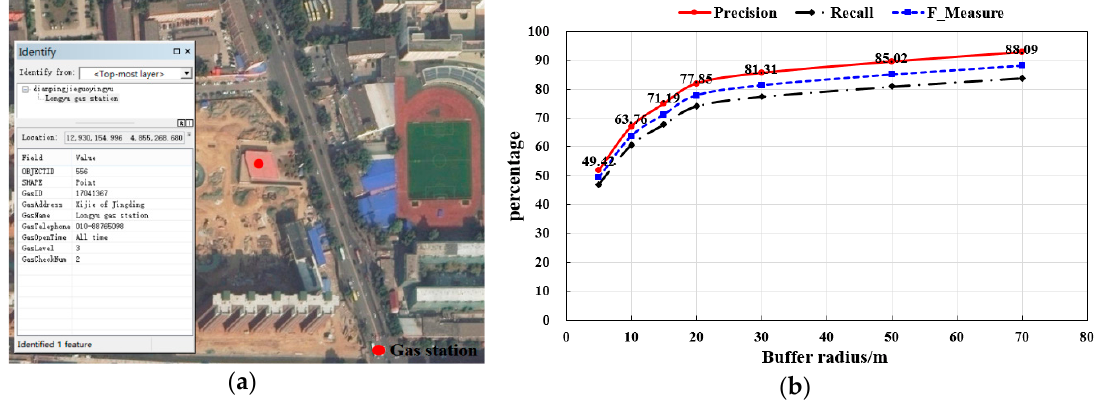
Figure 12. The experimental results analysis and evaluation. ( a ) Gas station point overlaid on remote sensing images (ID = 556); ( b ) Accuracy evaluation result of gas station.